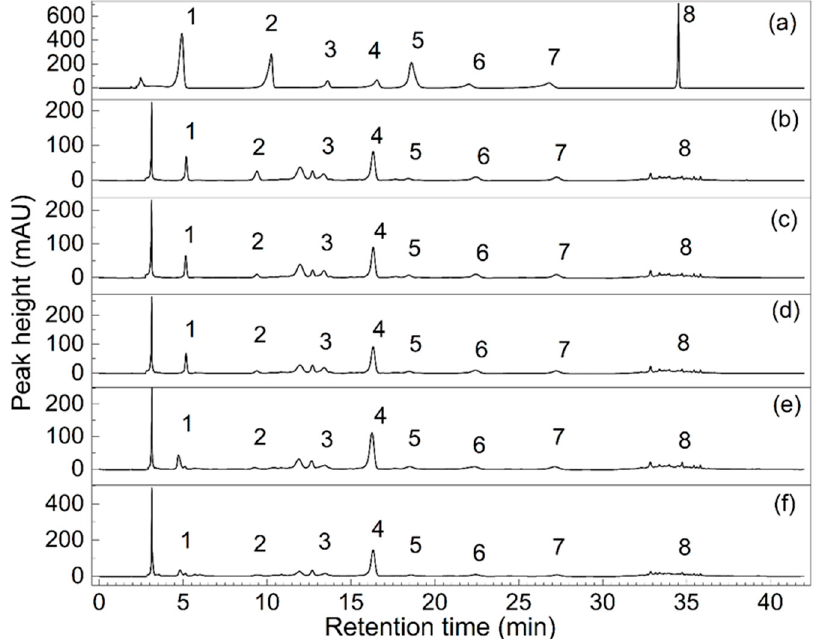
Figure 2. Chromatograms of phenolic standards and kiwifruit samples at different stages. ( a ) Represents the chromatogram of the mixed standard, and ( b – f ) are the chromatograms presented for the five stages: A, B, C, D, and E, respectively, where 1 is gallic acid, 2 is protocatechuic acid, 3 is procyanidin B1,4 is (+)-catechin, 5 is chlorogenic acid, 6 is procyanidin B2, 7 is ( − )-epicatechin, and 8 is isoquercitrin. Table 3. Changes in phenolic compounds and antioxidant potentials of kiwifruit at diverse post- ripening stages.